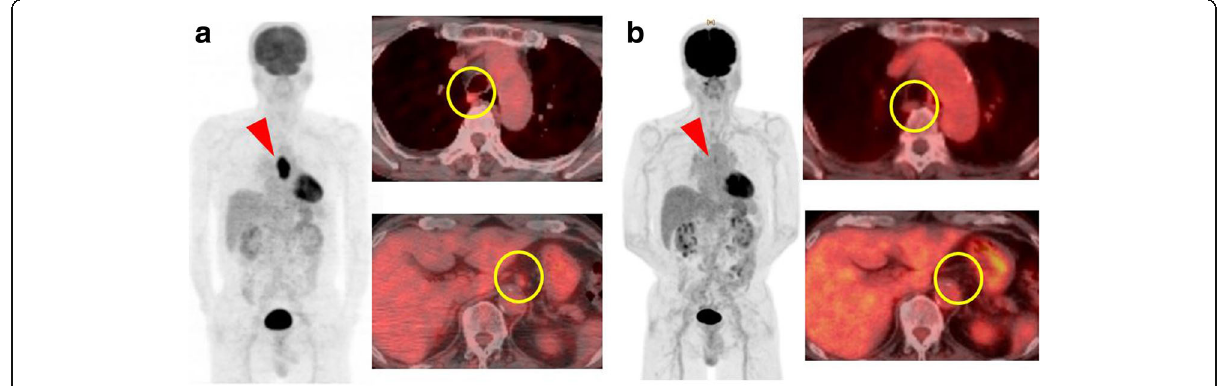
Fig. 5 Fluorodeoxyglucose-positron emission tomography (FDG-PET) findings. a Before preoperative chemotherapy, there was high FDG uptake by the tumor in the esophagus (a red arrow) and the swollen lymph nodes in the mediastinum and around the cardia (yellow circles). b After preoperative chemotherapy, the tumor had almost disappeared (a red arrow) and the swollen lymph nodes in the mediastinum and around the cardia had decreased (yellow